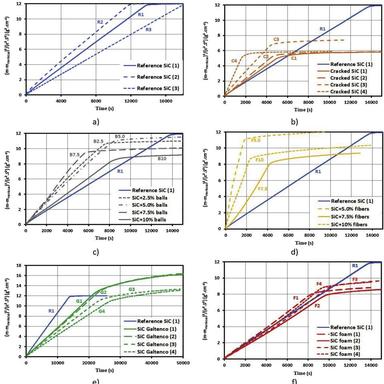
Time dependence of the squared weight gain curves normalized to the section during hexadecane capillary rise compared to reference SiC (1): a) reference SiC, b) cracked SiC, c) SiC + balls, d) SiC + fibers, e) SiC supplied by Galtenco, and f) SiC foams supplied by SICAT.